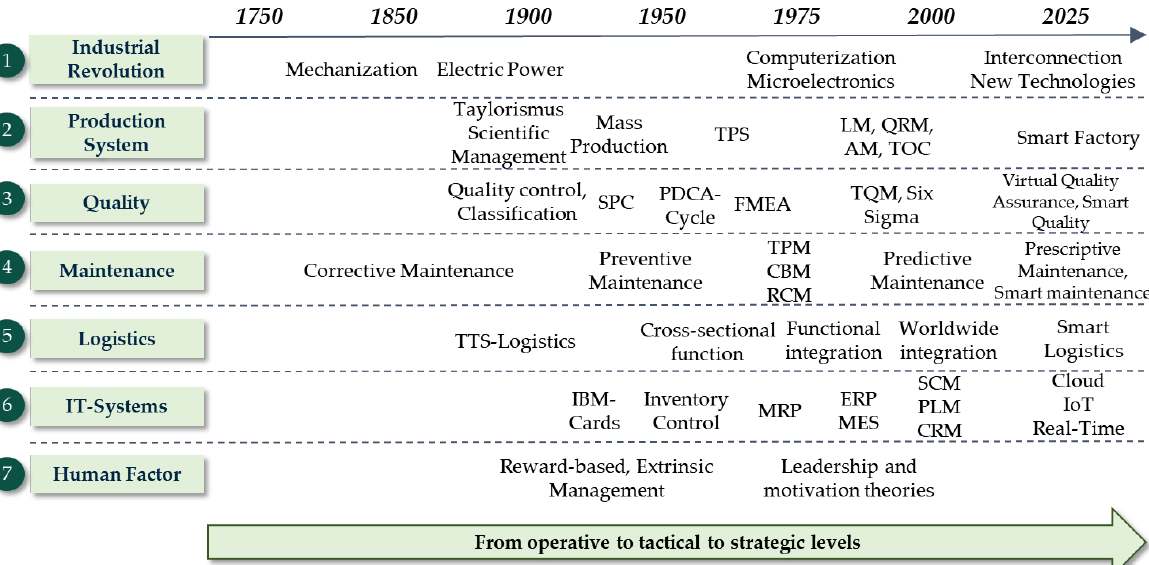
Figure 1. Function evolutions over time: seven manufacturing areas from operative to strategic levels (the authors’ own